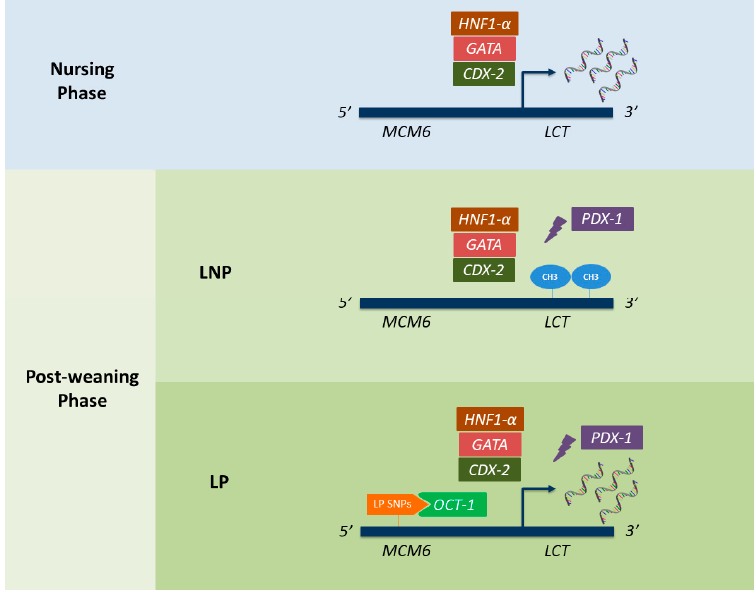
Figure 2. Genetic mechanisms underlying lactose persistence (LP) and lactase non-persistence (LNP) in humans. Rectangular shapes represent all the transcription factors currently known to interact with the lactase gene (LCT) promoter. While CDX-2, HNF1- α , GATA, and OCT-1 are known to promote LCT expression, the PDX-1 has been described as a transcriptional repressor. Oval shapes (named as “CH3”) refer to the appearance of methylations within the LCT region, which have also been described as repressing LCT expression. Finally, the di ff erent LP-associated alleles described in MCM6, and responsible for binding to OCT-1, are represented in orange. CDX-2: caudal type homeobox 2; HNF1- α : hepatocyte nuclear factor 1 α ; OCT-1: octamer-binding protein 1; PDX-1: pancreatic and duodenal homeobox